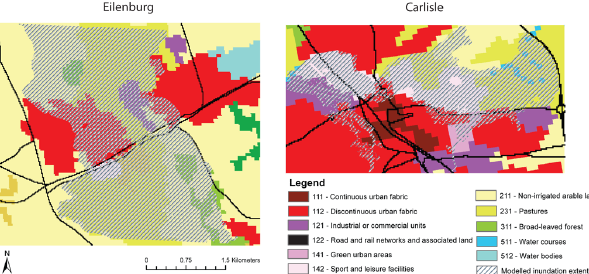
Fig. 4. The case study areas of Eilenburg and Carlisle with the land use and inundation data used in this study. The land use data con- sist of CORINE 2006 (EEA, 2009) and manually added main roads from ESRI Europe Base Map (ESRI, 2009). The inundation areas are derived from various modelling efforts that are further explained in Sect. 2.2.1.